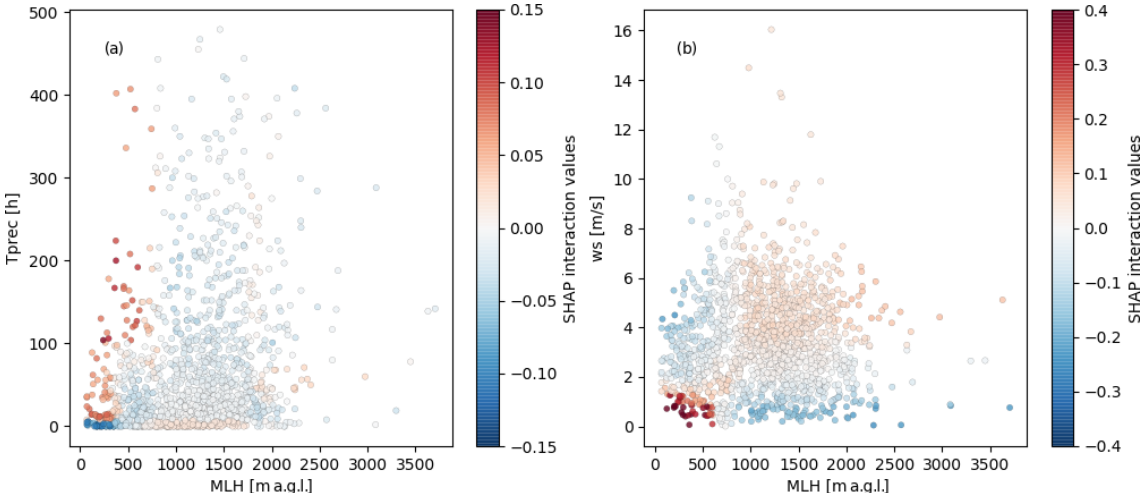
Figure 8. MLH vs. (a) time since last precipitation and (b) maximum wind speed, coloured by the SHAP interaction values for the respective features. Table 1. Statistics for typical PM 1 concentrations (mean, median, IQR) and high-pollution concentrations ( > 95th